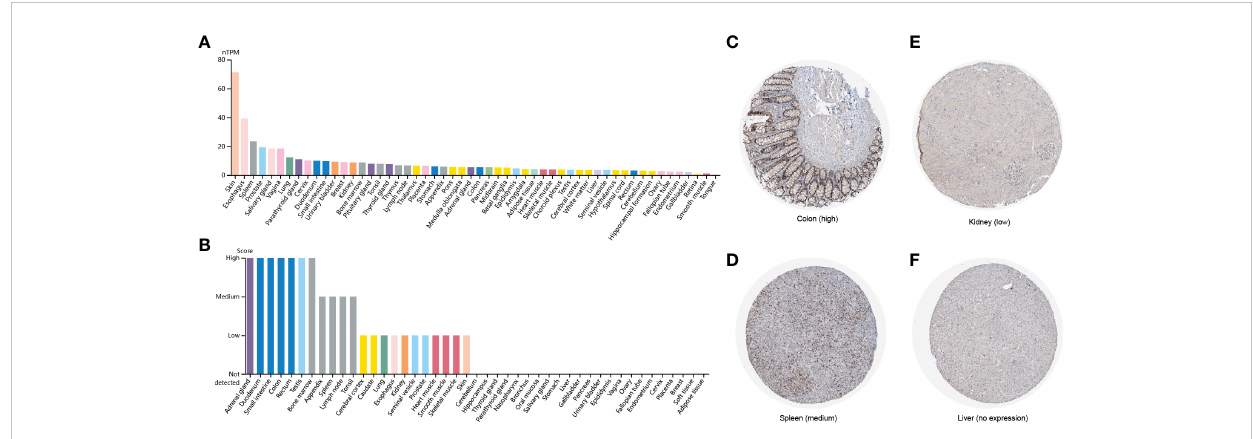
FIGURE 1 FAM110A expression in various human normal tissues. (A) FAM110A mRNA expression pro fi les in normal human tissues. (B) FAM110A protein expression data in human normal tissues. (C – F) Representative IHC images of FAM110A expression in normal colon, spleen, kidney, and liver